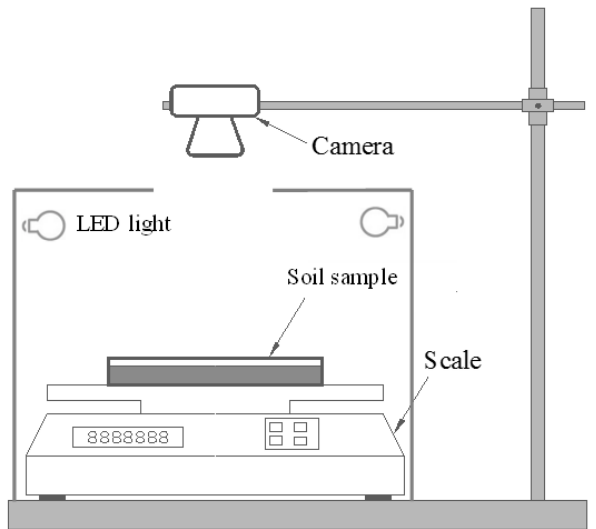
Figure 2. Schematic view of the experimental setup for bentonite desiccation test. 165